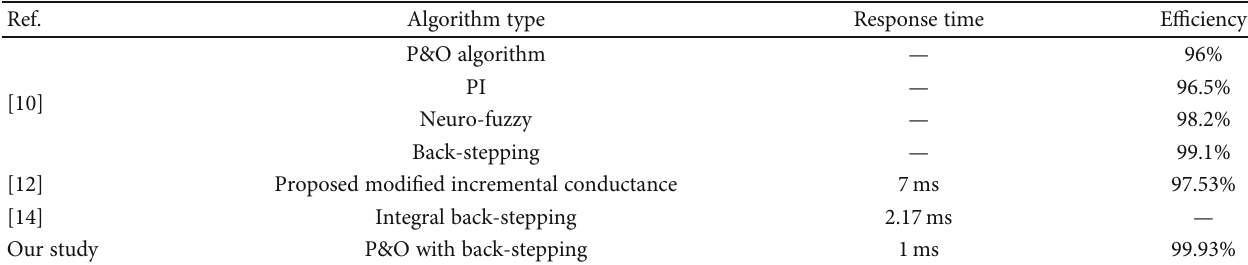
Table 4: Performance comparison of MPPT algorithms.